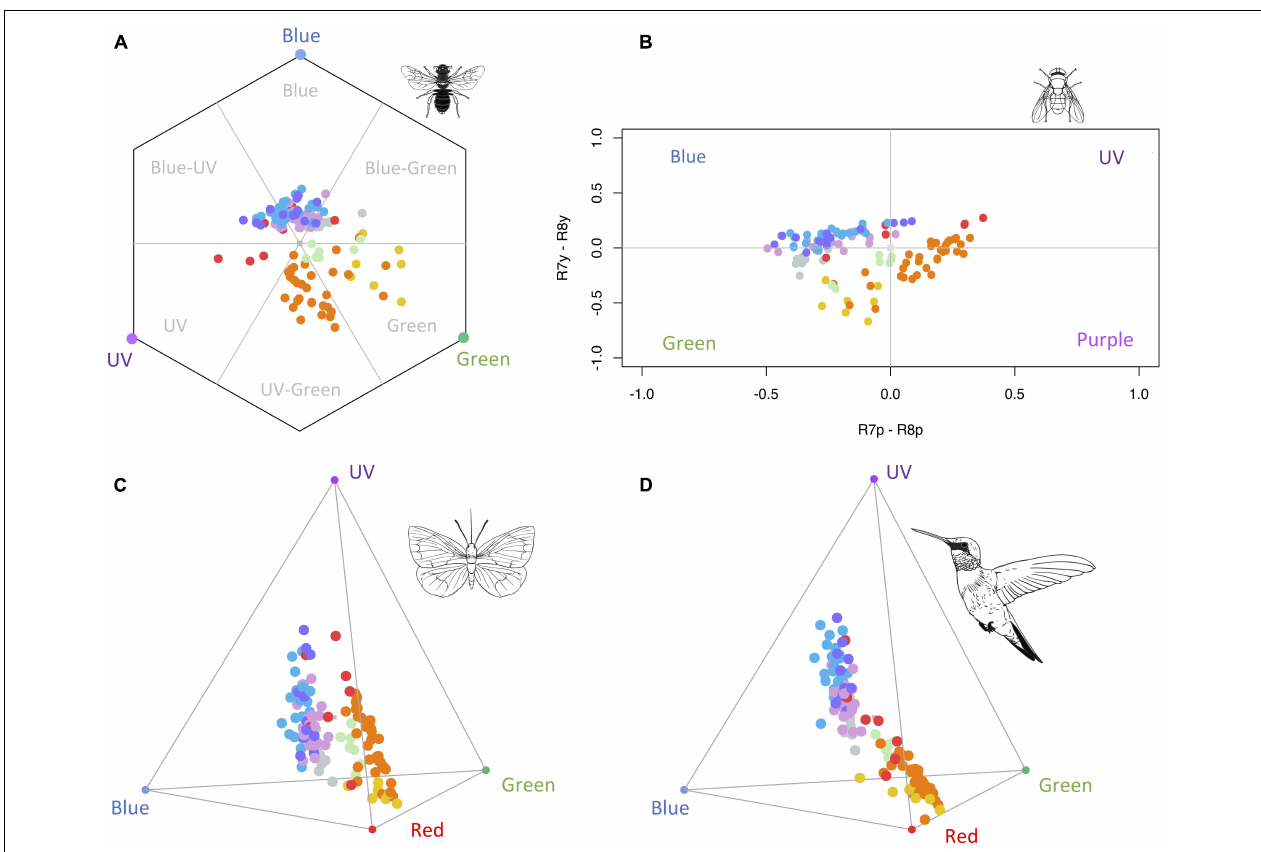
FIGURE 2 | Colour loci of species used in the study according to different colour vision models. The 123 colour loci are represented in the hexagon colour space for the trichromatic vision of bees (A) , the categorical colour space for the tetravariant visual system of flies (B) , the tetrachromatic colour space model for butterflies (C) , and the tetrahedral colour space model for birds with VS vision system (D) . Coloured blue, green, purple, and red circles in each vertex represent the maximum signals in the blue, green, UV, and red photoreceptors. Colour loci correspond to each pigment group: green (chlorophylls), orange (carotenoids), grey (UV-absorbing flavonoids), yellow (aurones-chalcones), pink (cyanidins), red (pelargonidins), blue (delphinidins), and purple (malvidins). See Supplementary Figures 2–5 for individual representations of each pigment group in the four colour vision models. Animal silhouettes taken from Divulgare (www.divulgare.net) under a Creative Common